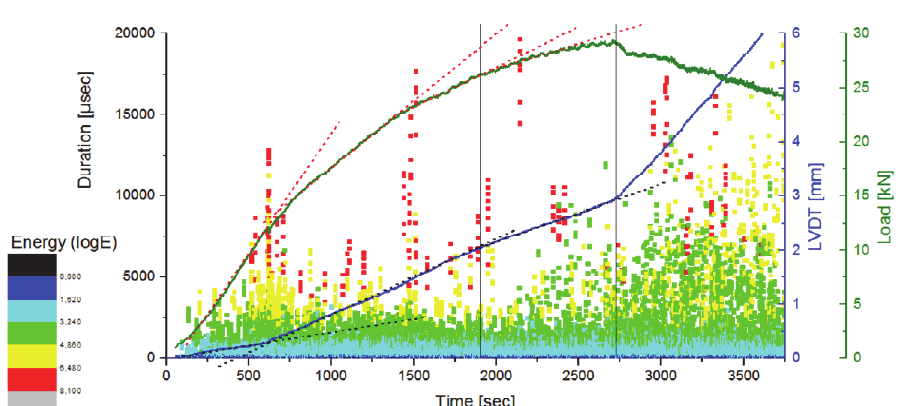
Figure 2: Time variation of the duration of AE recordings, the LVDT (in touch with the bar’s lowest end) indications and the load [3].